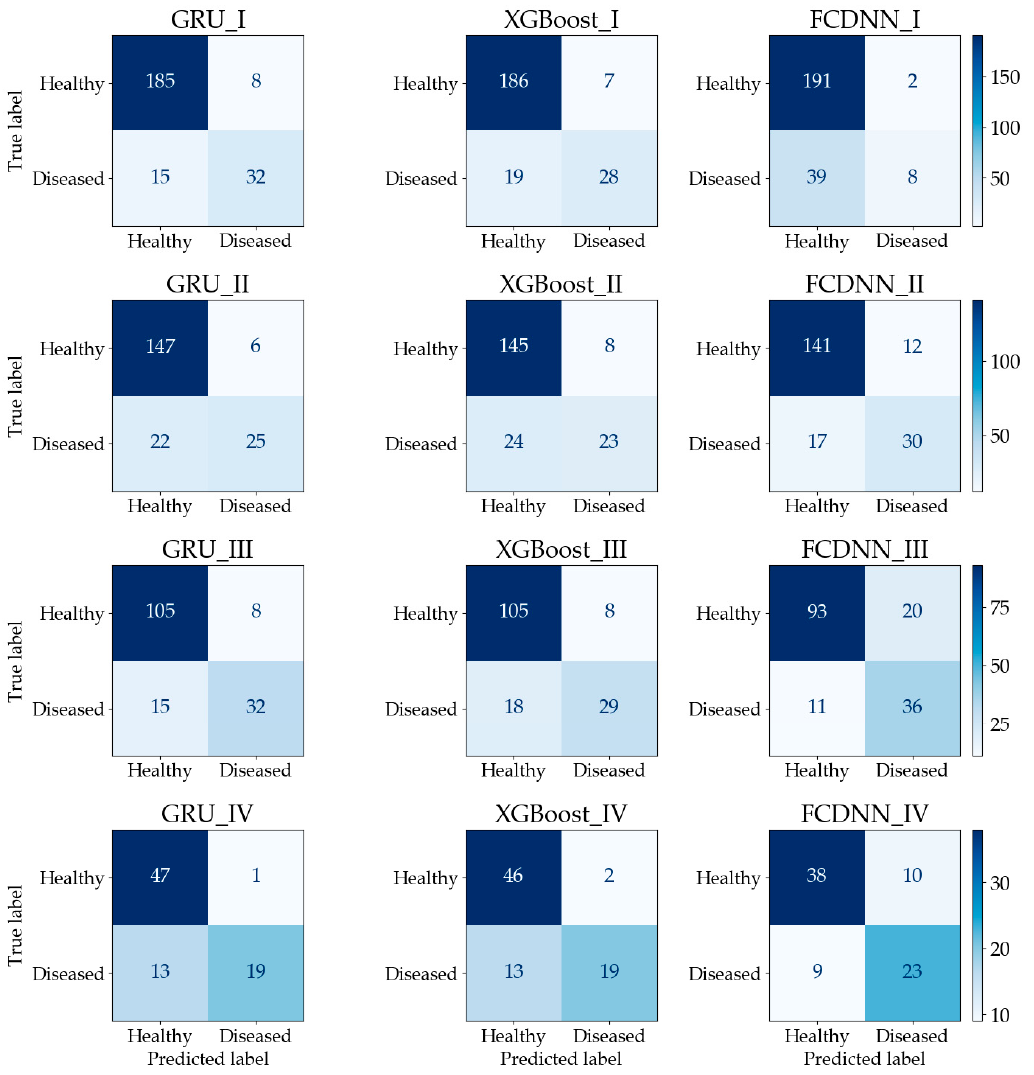
Figure 7. Confusion matrix of the testing dataset (each figure is named as “[method name]_[calculation number]”).